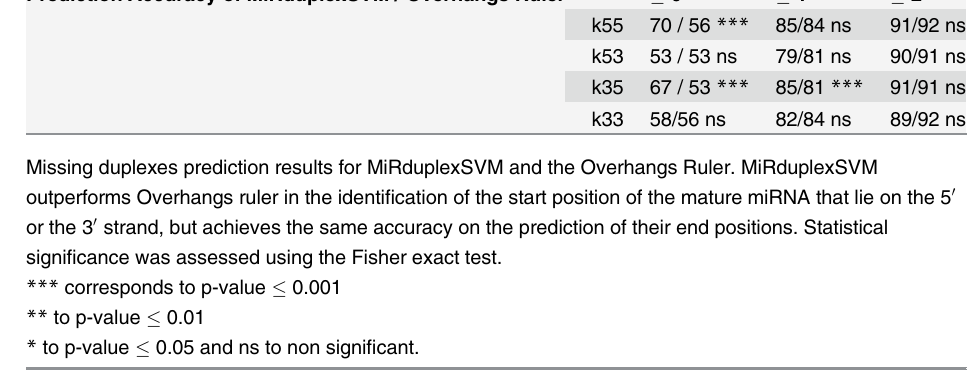
Table 2. End Absolute Error (EAE) in nts. Prediction Accuracy of MiRduplexSVM / Overhangs Ruler